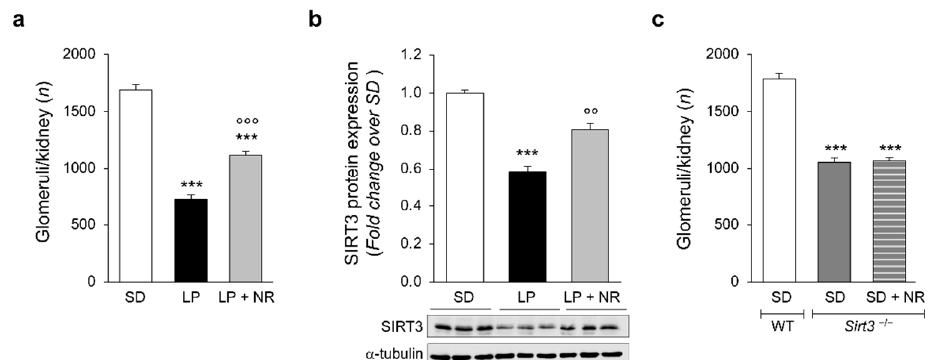
Figure 1. NR supplementation restores nephron number and SIRT3 expression in the kidneys of maternal LP diet offspring. ( a ) Glomerular number quantified in the kidney of newborn mice (day 1) born to mothers fed a SD during pregnancy or a LP diet supplemented or not with NR; n = 14 kidneys from 14 newborn mice for each group. ( b ) Representative Western blots and densitometric analysis of SIRT3 protein expression in total kidney extracts harvested from newborn mice (day 1) from mothers fed with SD ( n = 8 samples), LP diet alone ( n = 9 samples) or with NR ( n = 9 samples). Each sample consisted of a pool of at least 4 kidneys from 4 newborn mice. ( c ) Quantification of the glomerular number in kidneys of the offspring of WT ( n = 12 kidneys from 12 newborn mice) or Sirt3 − / − mice fed a SD supplemented or not with NR during pregnancy ( n = 11 and n = 14 kidneys from 11 and 14 newborn mice, respectively). Results are presented as mean ± SEM and were analyzed with ANOVA with Tukey’s post hoc test. *** p < 0.001 vs. SD; ◦◦ p < 0.01, and ◦◦◦ p < 0.001 vs.